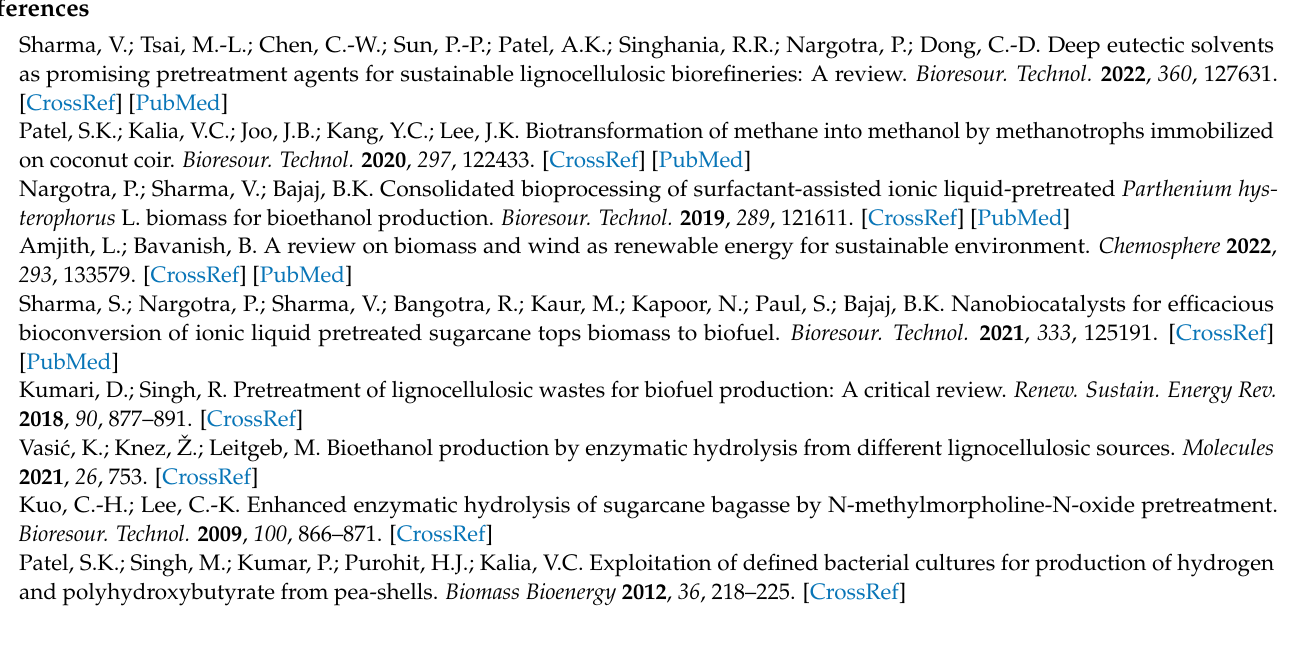
Table S1: Escherichia coli strains and plasmids used in the